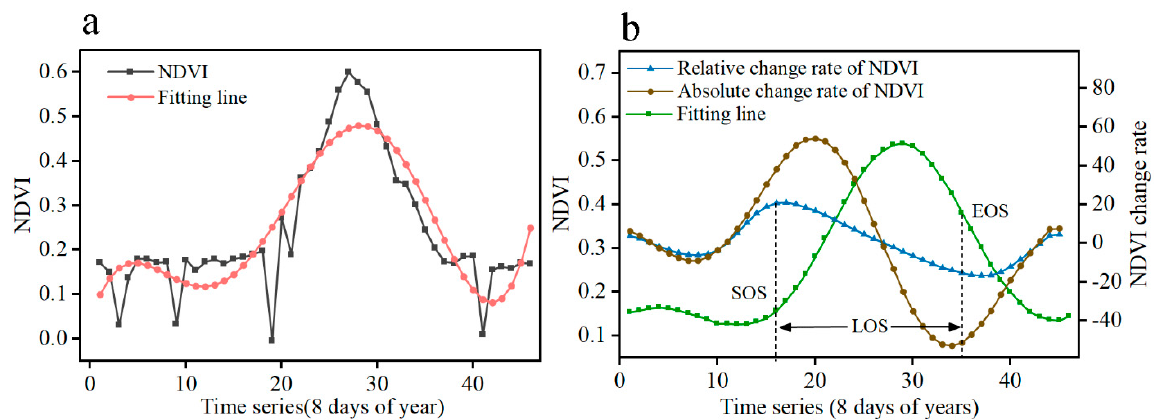
Figure 3. ( a ) Fitting effect of the harmonic analysis of time series; ( b ) definition of the normalized difference vegetation index (NDVI), threshold of the start of the growing season (SOS), and end of the growing season (EOS). The green line is the NDVI time-series change curve of 8 days after smooth treatment. The vertical axis of the left side is the NDVI value, and the vertical axis of the right side is the change rate of NDVI. For comparison, the change rate of NDVI has been zoomed in integer times, the ratio of absolute change value is 1000, and the ratio of relative change rate is 100.